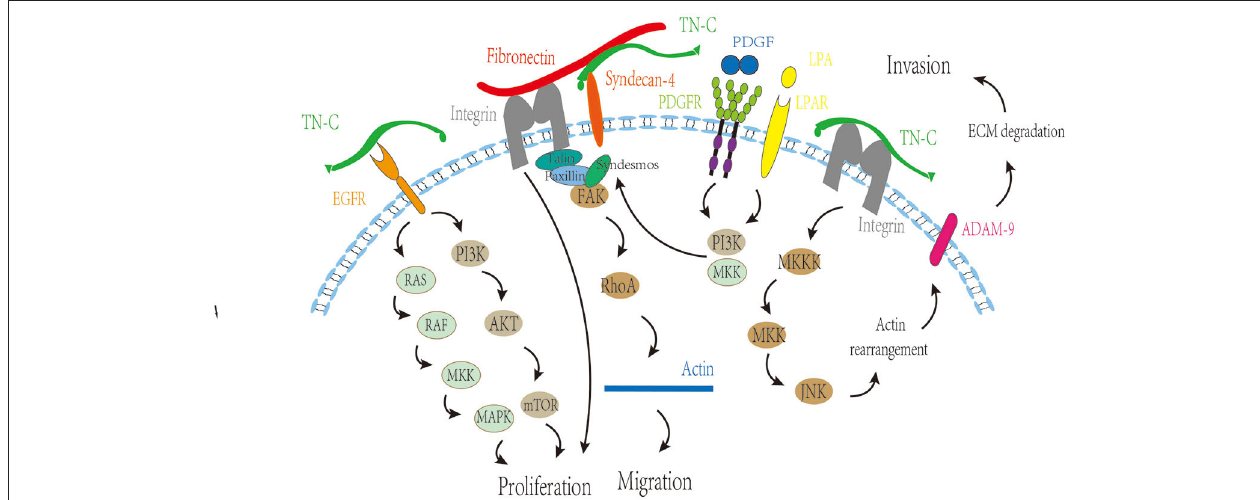
FIGURE 3 | Regulatory function of TN-C on angiogenesis, proliferation, migration, and invasion of glioma cells. MKK, MAP kinase kinase; MAPK, mitogen-activated protein kinase; PI3K, phosphatidylinositol 3-kinase; mTOR, mammalian target of rapamycin; FAK, focal adhesion kinase; PDGF, platelet-derived growth factor; PDGFR, platelet-derived growth factor receptor; LPA, lysophosphatidic acid; LPAR, lysophosphatidic acid receptor; ADAM9, A disintegrin and A metalloproteinase-9; ECM, extracellular matrix.